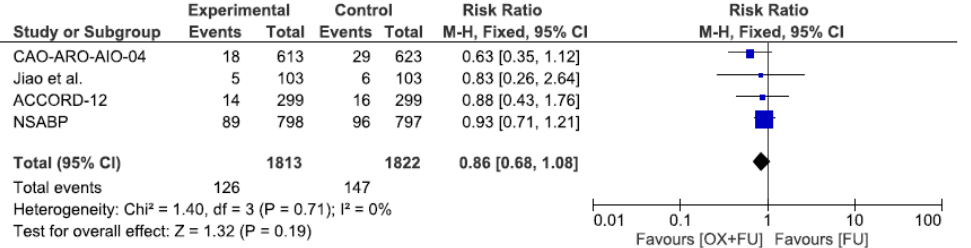
Figure 5. Forest plot of risk ratio for metastatic progression. 3.6. R0 Resection R0 resection rate was reported in six studies, corresponding to a total of 4097 patients. The R0 resection rate ranged from 86.3% to 97.1% in the oxaliplatin + 5FU group and from 87.3% to 95.2% in the 5FU only group, without statistical significance (92.5% vs. 91.9%, RR = 1.05, 95% CI: 0.66–1.67, p = 0.83, I 2 = 69%) (Figure 6). Figure 6. Forest plot of odds ratio for R0 Resection. 3.7. Toxicity Severe toxicities (grade 3–4) were reported in six studies, corresponding to a total of 5125 patients. Severe toxicity rates ranged from 21.4% to 40.1% in the oxaliplatin + 5FU